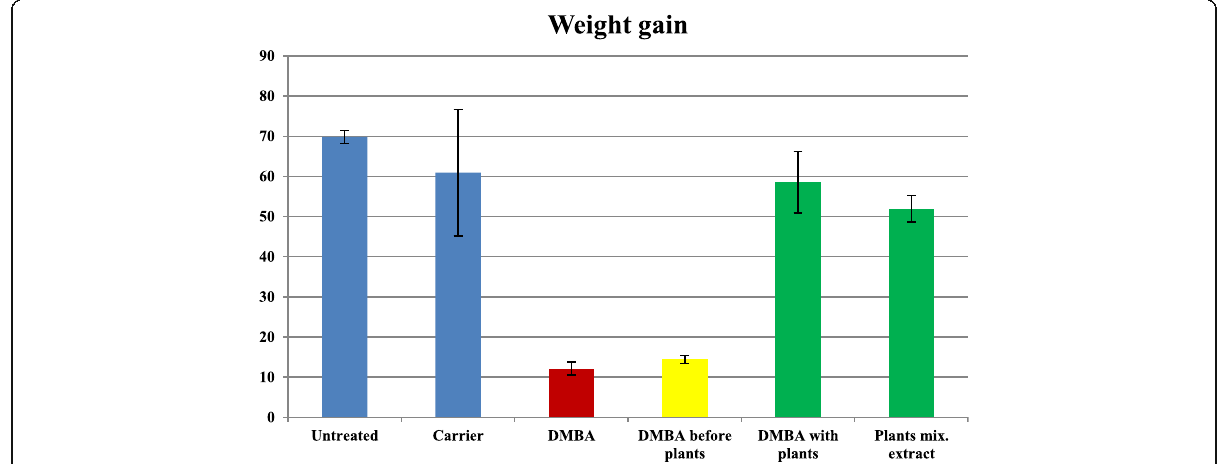
Fig. 1 Weight gain in the different rat groups. Standard errors are indicated on the bars and the significance levels are shown in Table